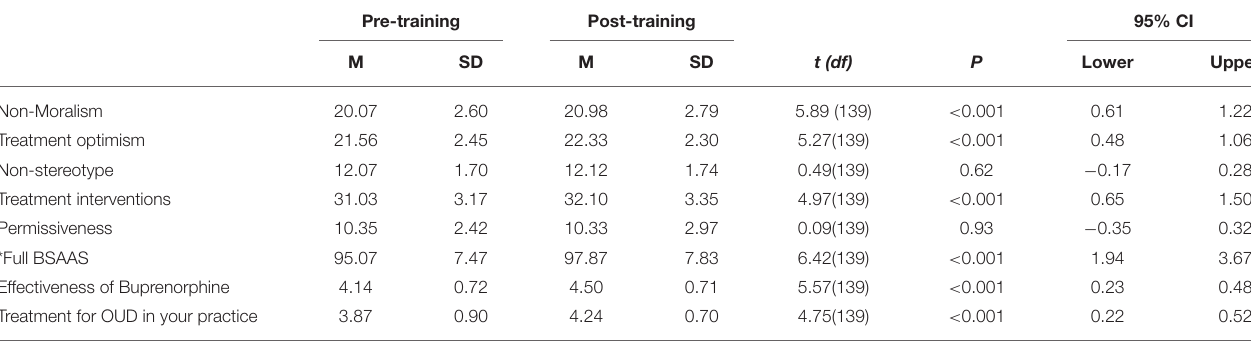
TABLE 3 | Summary of pre- and post-training